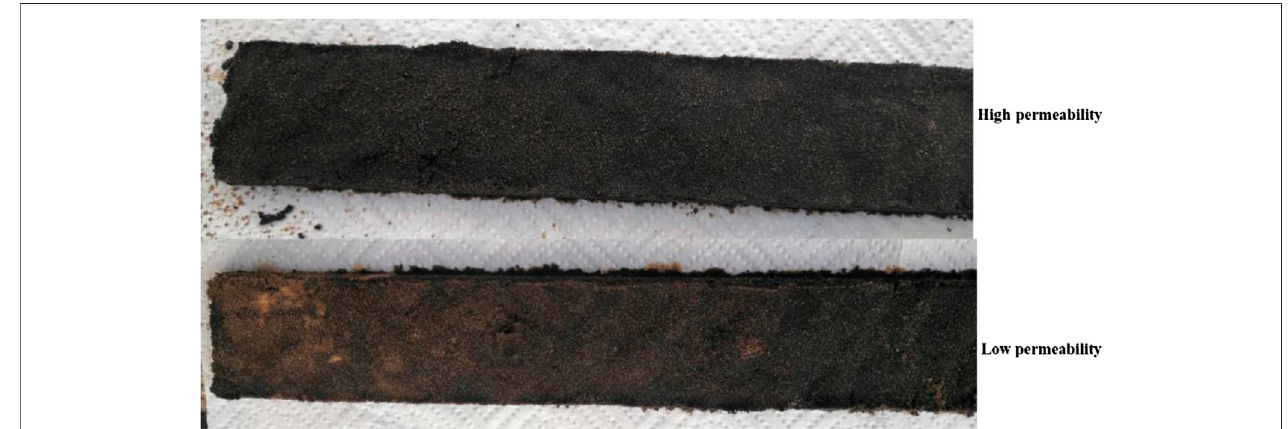
FIGURE 16 | Oil sands after huff-n-puff production process.